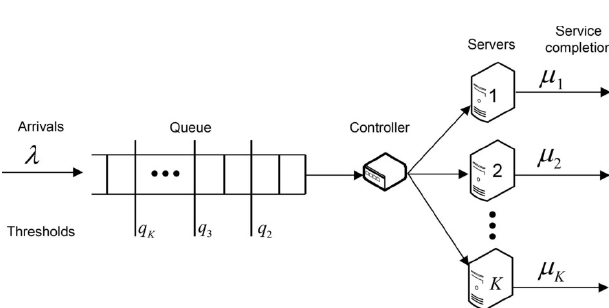
Figure 1. Controllable multi-server queueing system with heterogeneous